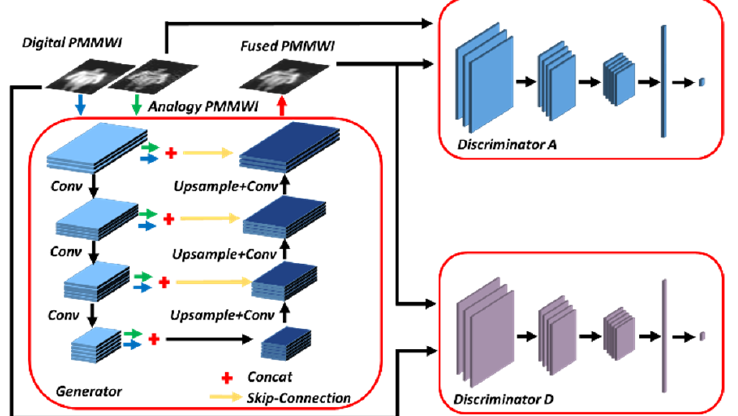
Figure 3. Architecture of the fusion network contains one Generator and two Discriminators.